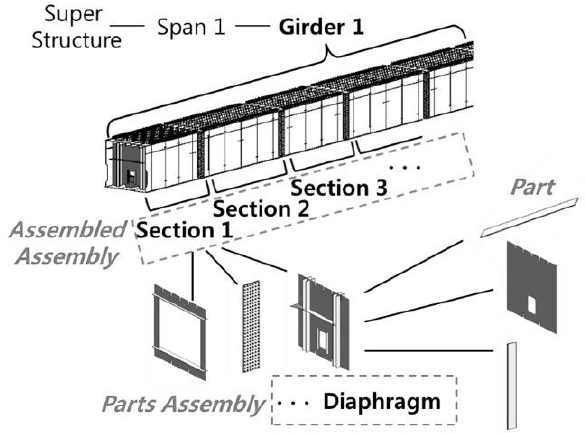
Figure 5. Physical representation of bridge components.